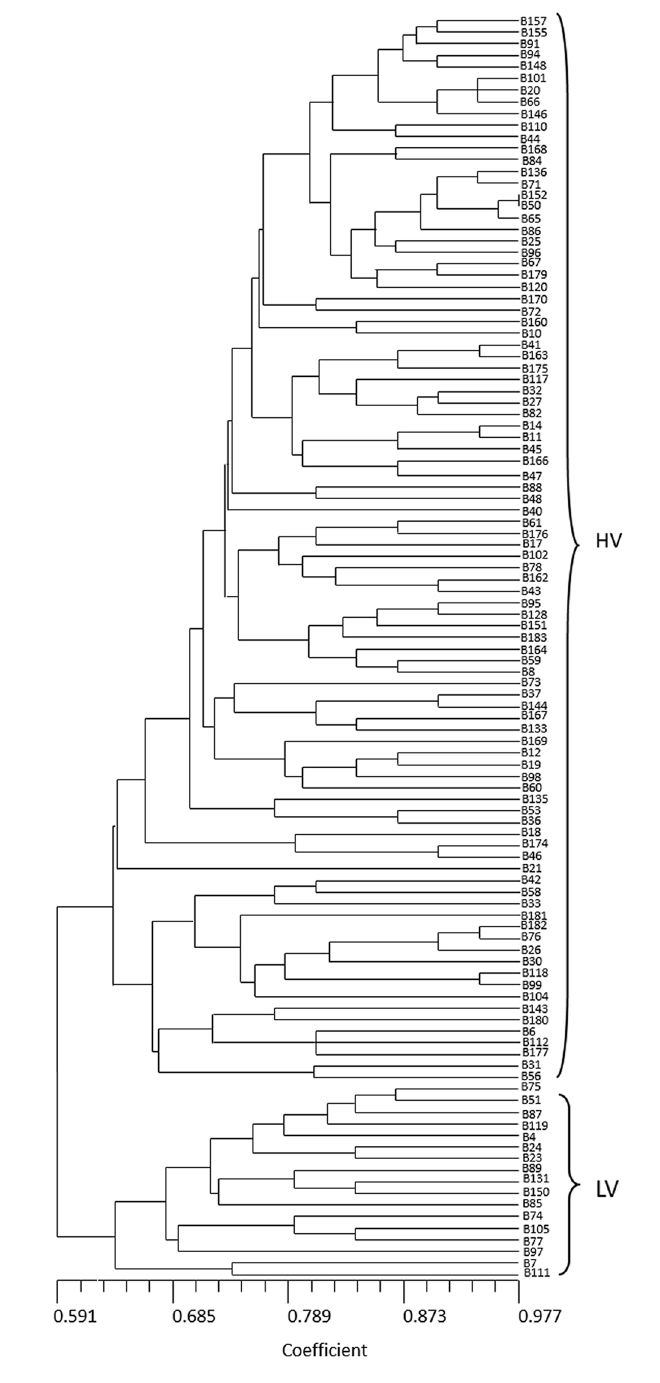
Fig 2. UPGMA dendrogram of Blumeria graminis f. sp. tritici strains based on the virulence data.